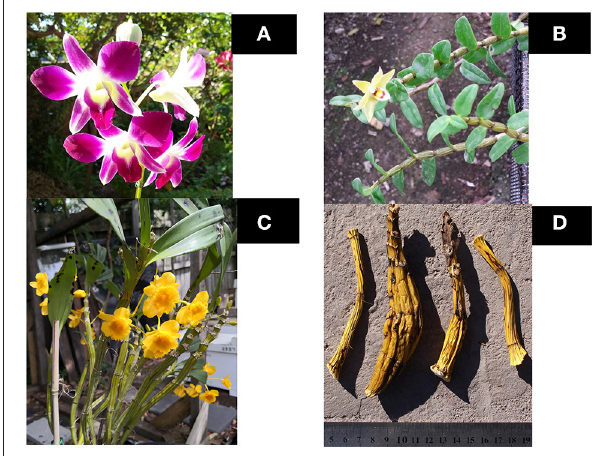
FIGURE 1 | Representative species of Dendrobium genus. (A) Dendrobium nobile ; (B) D. officinale ; (C) D. chrysotoxum ; (D) Dry herb of D. chrysotoxum .